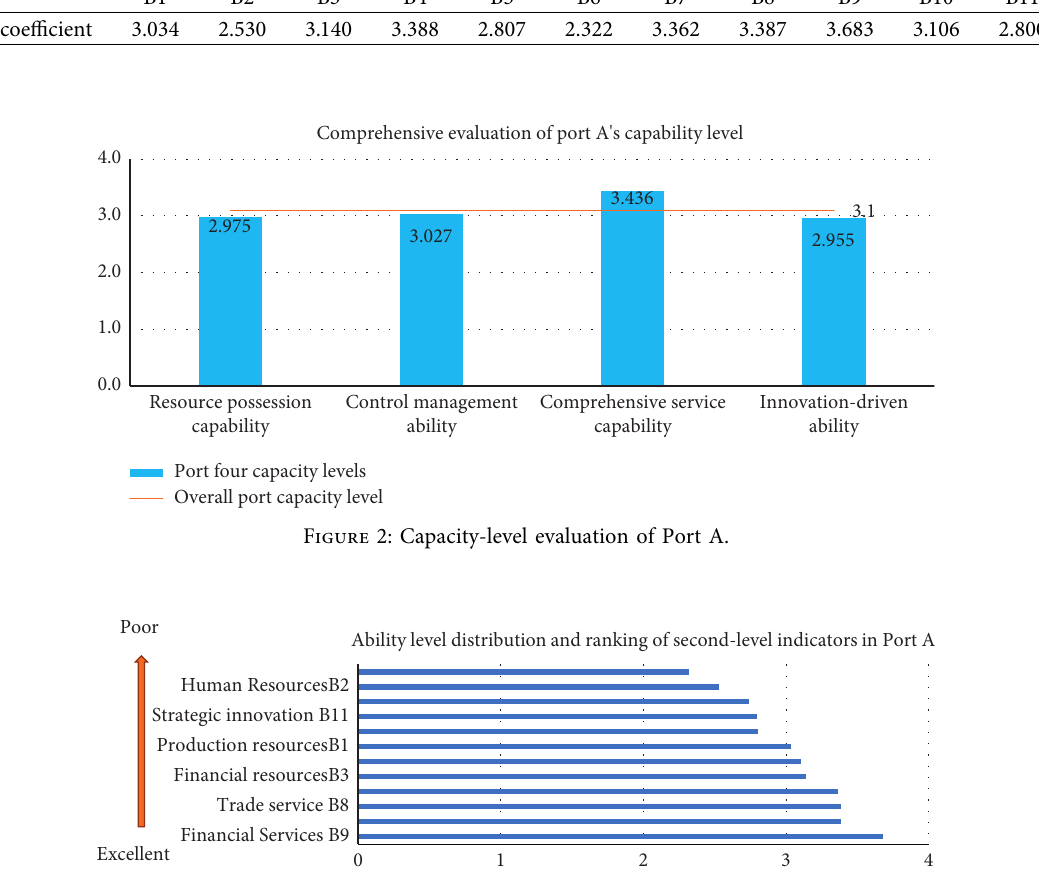
Figure 3: Capacity-level distribution and ranking chart of secondary indicators of Port